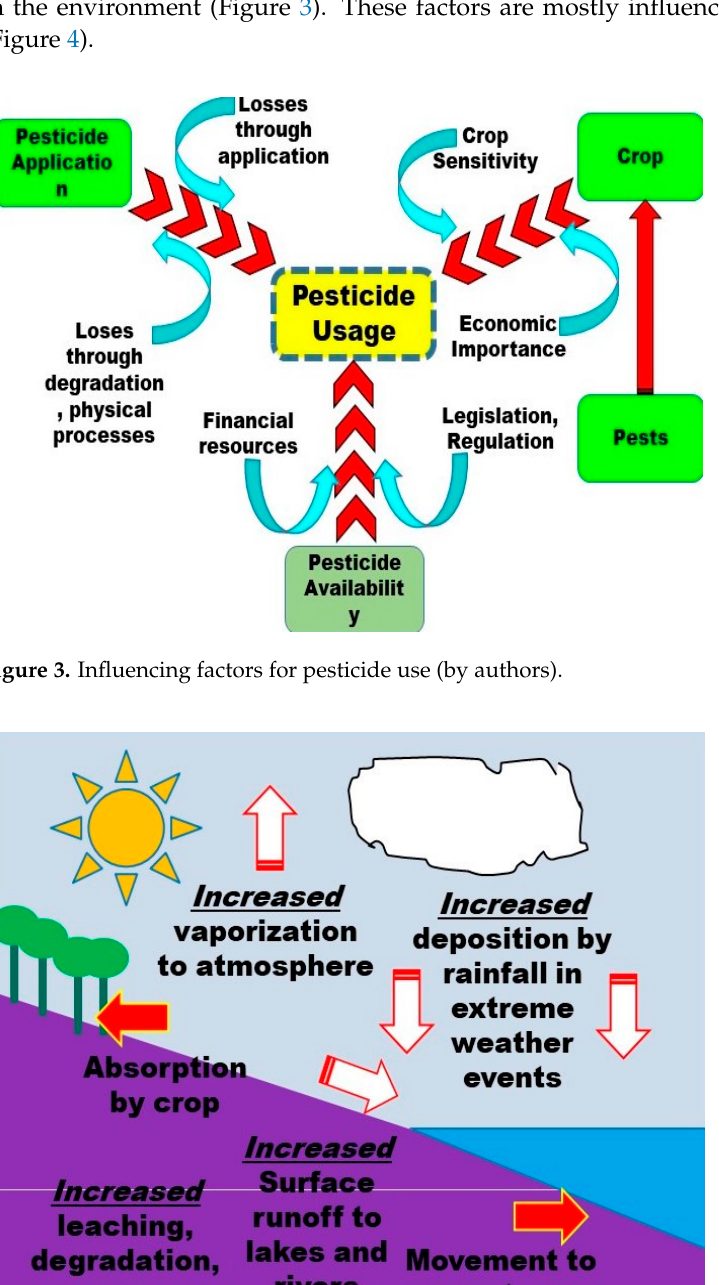
Figure 2. Pesticide behavior in the natural environment (by authors).